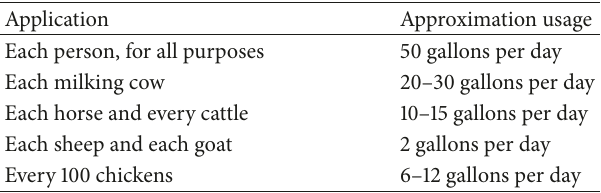
Table 1: Daily water requirement for some